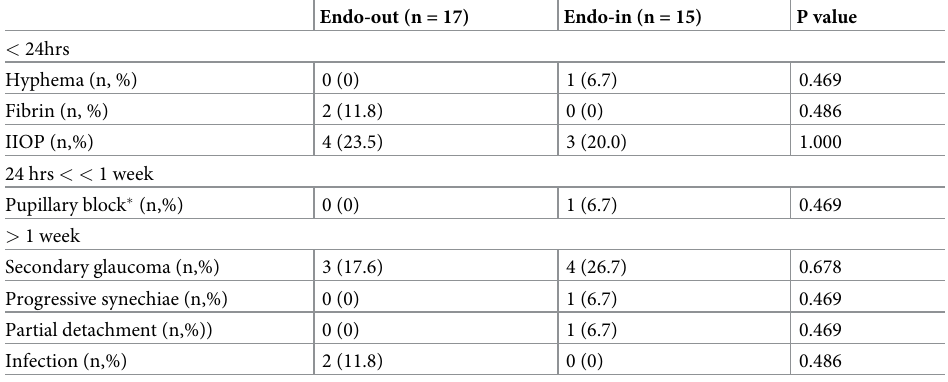
Table 3. Postoperative complication after